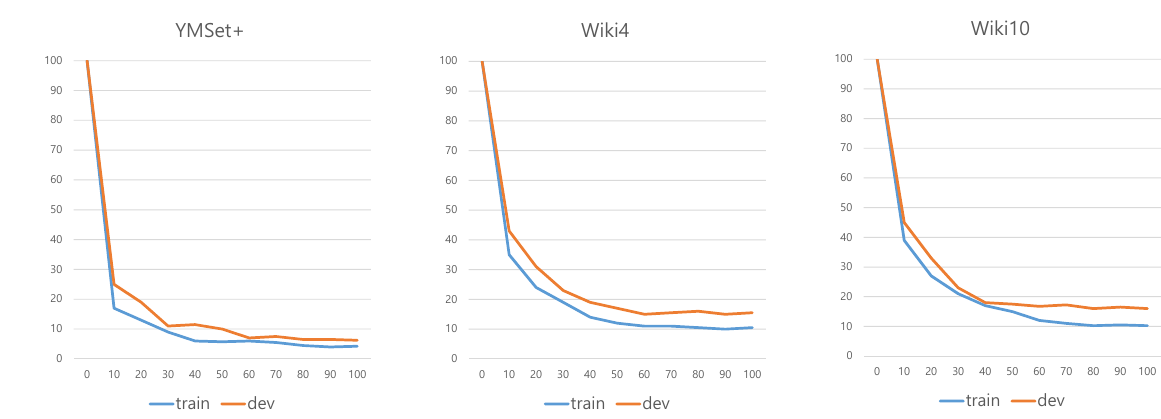
Figure 15. Decrease of error for the training